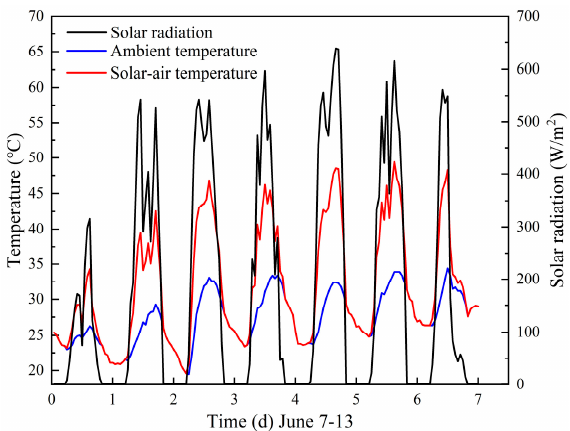
Figure 7. The solar–air temperature of Zhengzhou city [30].